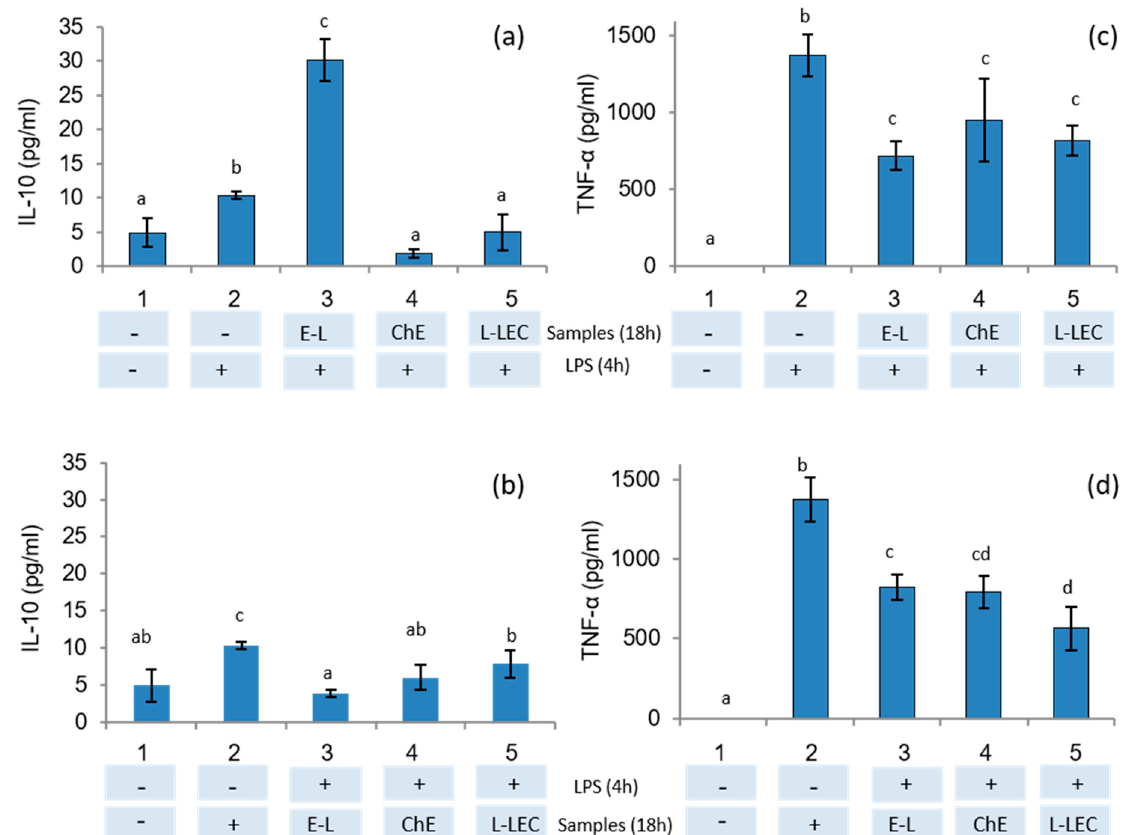
Figure 5. IL-10 and TNF- α secretion in THP-1 cells differentiated into macrophages tested by ELISA kit. ( a , c ) Cells were treated with samples E-L (500 µg/mL), chia extract (160 µg/mL), and L-LEC (660 µg/mL) for 18 h and then stimulated with LPS (1 µg/mL) for 4 h. ( b , d ) Cells were stimulated first with LPS and then treated with the samples. 1: control cells, 2: control cells treated with LPS, 3 E-L, 4: ChE, and 5: L-LEC. E-L: empty liposomes; ChE: chia extract; and L-LEC: liposomes made of rapeseed lecithin loaded with chia extract. Different letters (a,b,c) indicate significant differences ( p < 0.05) among